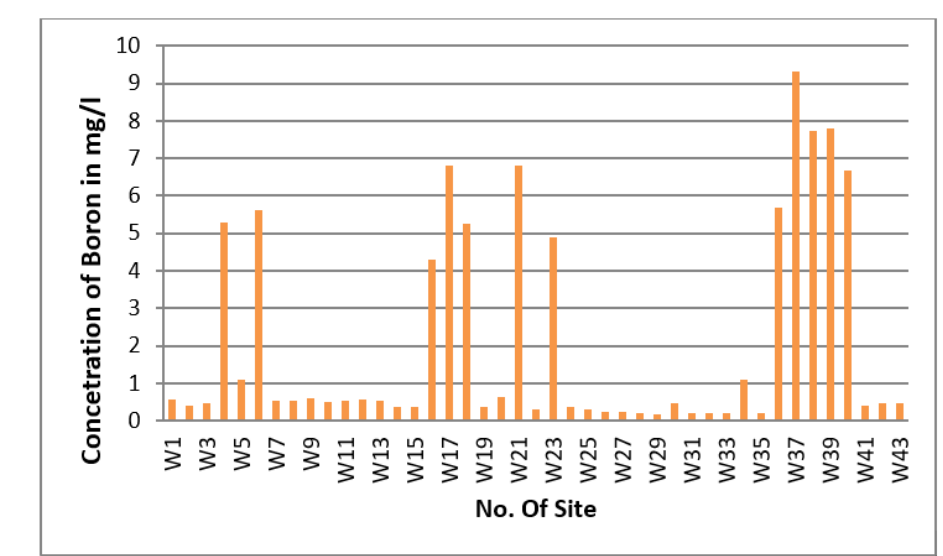
Fig. 3. In the southern Basrah governorate boron concentration in water wells and water samples using